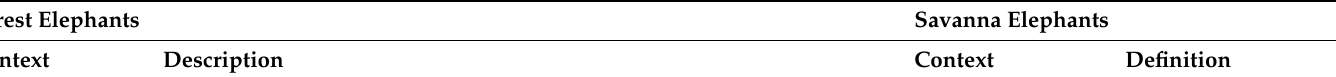
Table 1. Behavioural contexts of rumbles, roars and rumble-roar combinations produced by forest elephants at Dzanga Bai, and corresponding contexts for savanna elephants, as defined in The Elephant Ethogram [41] *. To make this direct comparison, we have aligned contexts defined in The Elephant Ethogram to match the broader contexts described for forest elephants. The rumble sub-types, roars and combination calls listed in parentheses are those included in our preliminary analyses in Figures 2–5 and do not represent all rumbles (e.g., husky-cries or “grunts” by new-borns, baroo-rumbles) or call-types (e.g., trumpets, nasal trumpets, snorts) given in these contexts. To attempt the best fit with forest elephant contexts, savanna elephant calls categorized under the context Protest and Distress have been divided into Protest versus Distress, and those categorized under Calf Reassurance and Protection have been separated into those that occurred in an affiliative versus separation